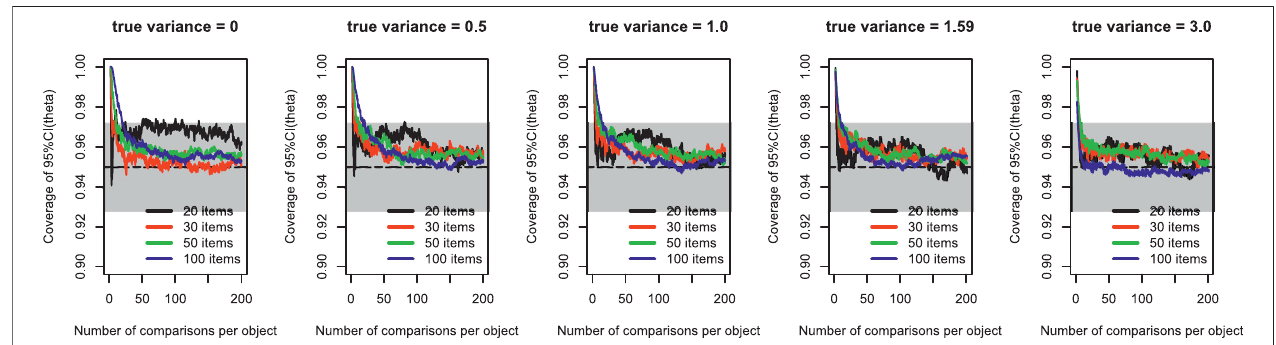
(cid:2) with increasing numbers of comparisons per item for all true